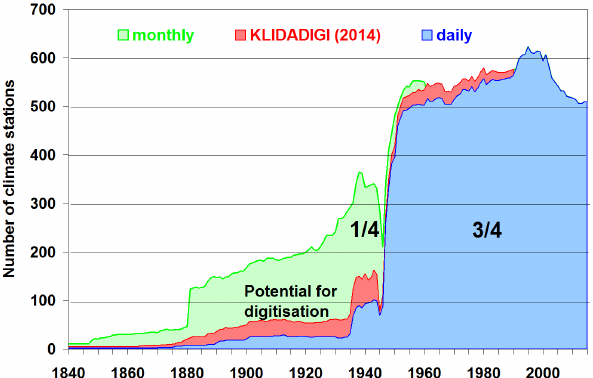
Figure 3. Temporal evolution of the digitally available temperature series and of the digitized records until the end of 2014 (the poten- tial for digitization is the portion of the digitized monthly data that is not yet available as digital daily